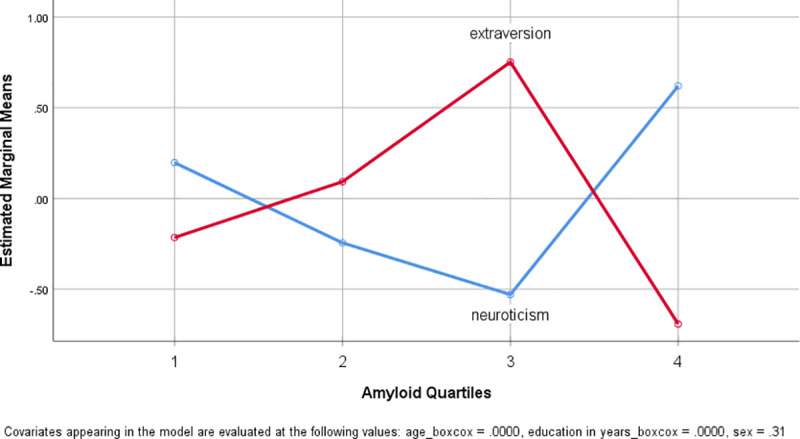
Plot of estimated marginal means of extraversion and neuroticism score against amyloid load.Plot of the estimated marginal means of the two NeoFFI measures as estimated in the repeated measures model with the covariates age, sex and education. Neuroticism against amyloid quartiles is plotted in blue and extraversion in red. Variables were Box-Cox transformed.